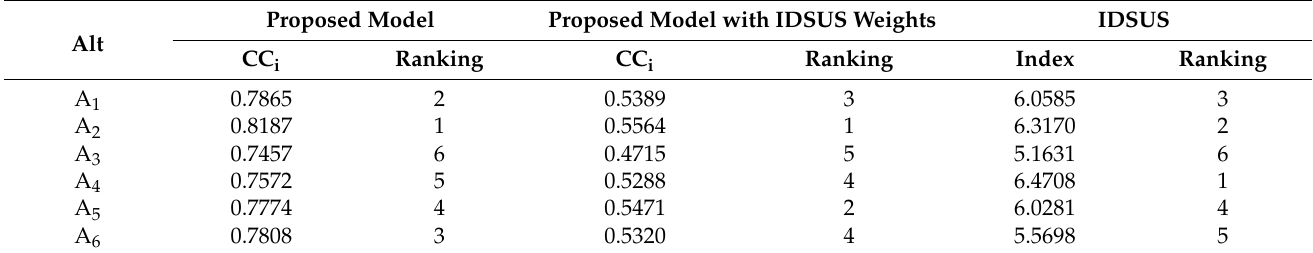
Table 5. Comparison of the